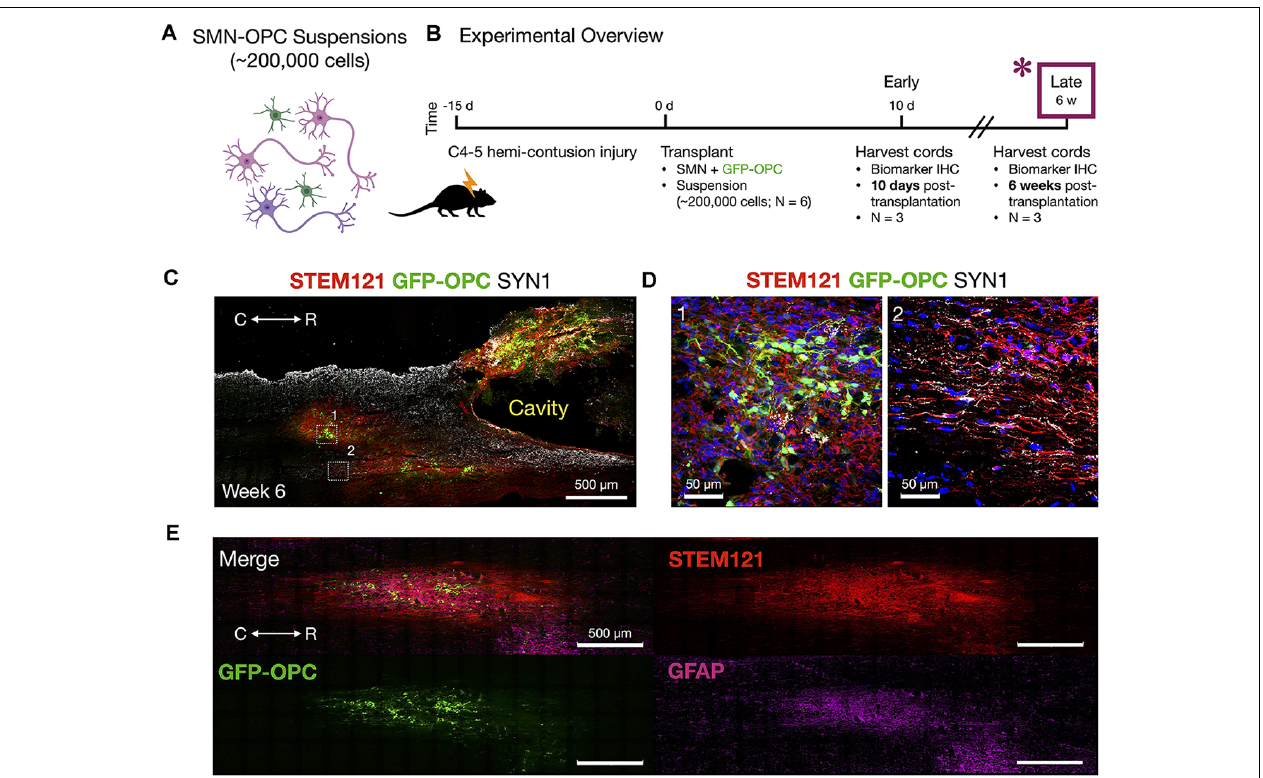
FIGURE 6 | Host tissue contusion site integration of SMN-OPC in vivo grafts. (A) Schematic overview of the SMN-OPC cell suspension grafts. Pink depicts spinal motor neurons, purple depicts spinal interneurons that co-differentiate, and green is GFP-OPCs. (B) Schematic overview of SMN-OPC cervical hemicontusion grafting experiment ( N = 6 animals). ∗ Data provided in this figure are from the 6 weeks time point. (C) Low magnification view of SMN-OPC suspension graft using STEM121 and SYN1 antibodies, and GFP to identify OPCs. White boxes (1, 2) denote high magnification fields shown in (D) . (D) Top: high magnification images of 6 weeks suspension grafts in the host spared spinal cord (1, 2) visualized with STEM121/GFP-OPC/SYN1/DAPI. Neuronal projections into spared host tissue have robust co-localization with SYN1. (E) Merged image and individual channels (STEM121/GFP-OPC/GFAP) demonstrates filling of the injury cavity and aligned fiber outgrowth in the host spared tissue. R (rostral), C (caudal). Individual scale bars are